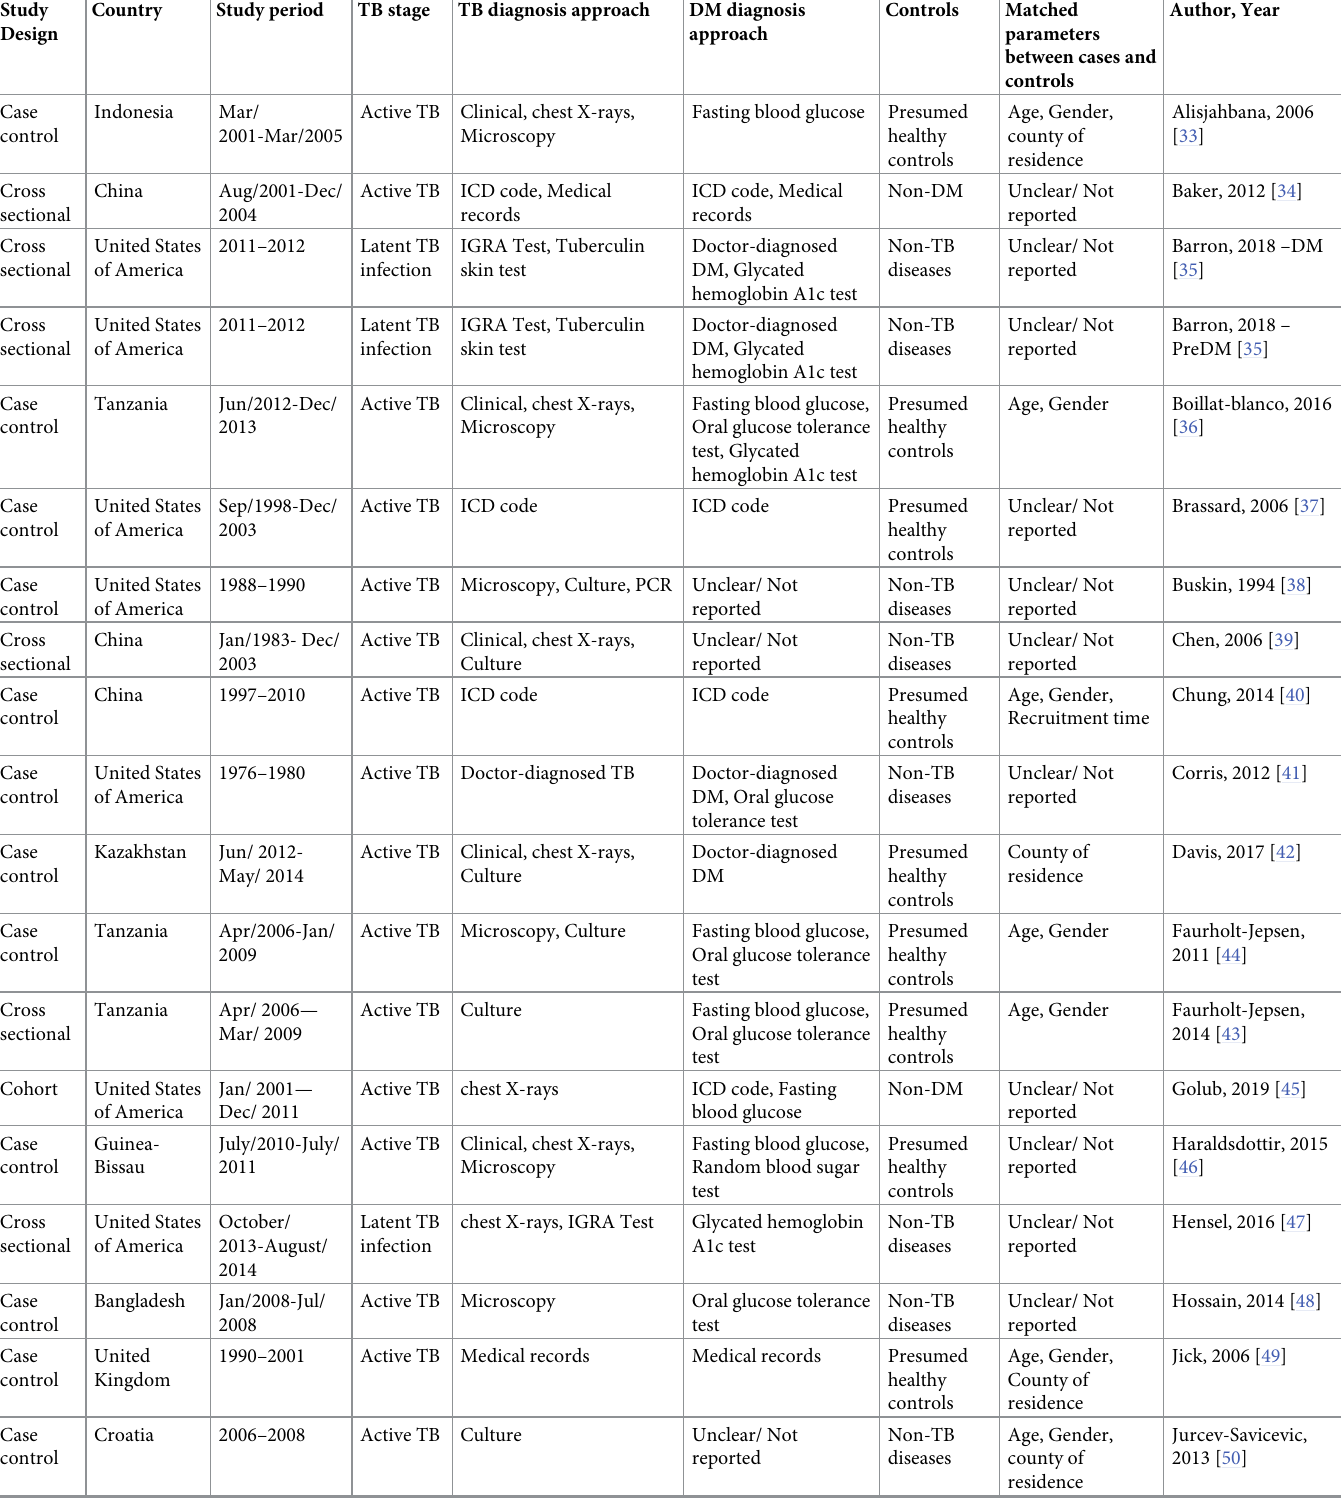
Table 1. Individual characteristics of included